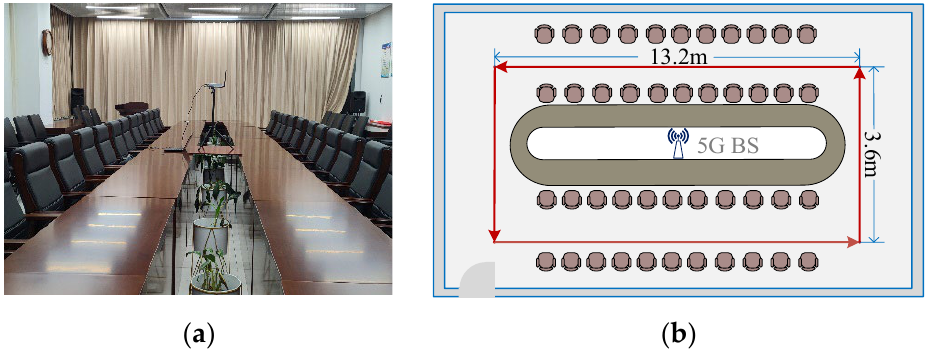
Figure 10. Conference room. ( a ) Scenario photograph. ( b ) Experimental approaches.